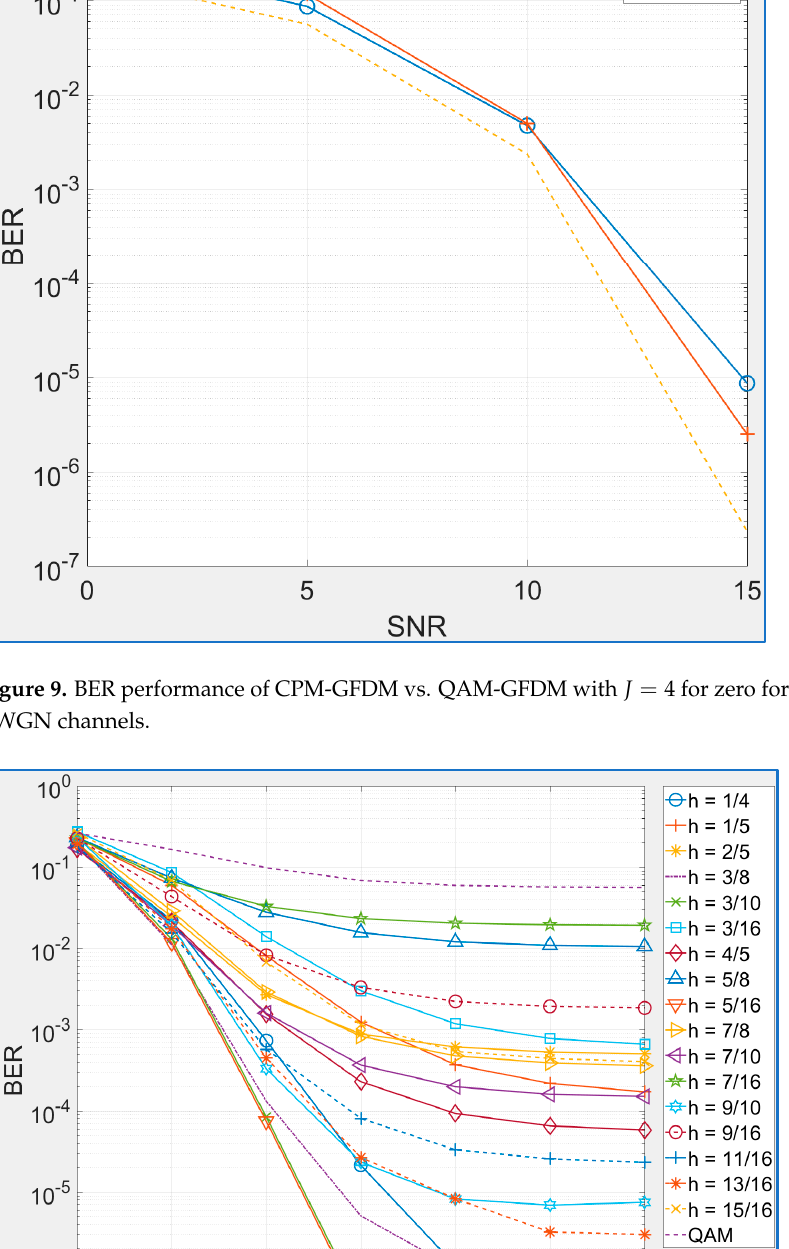
Figure 9 . BER performance of CPM-GFDM vs. QAM-GFDM with 𝐽 = 4 for zero forcing receiver over AWGN channels.